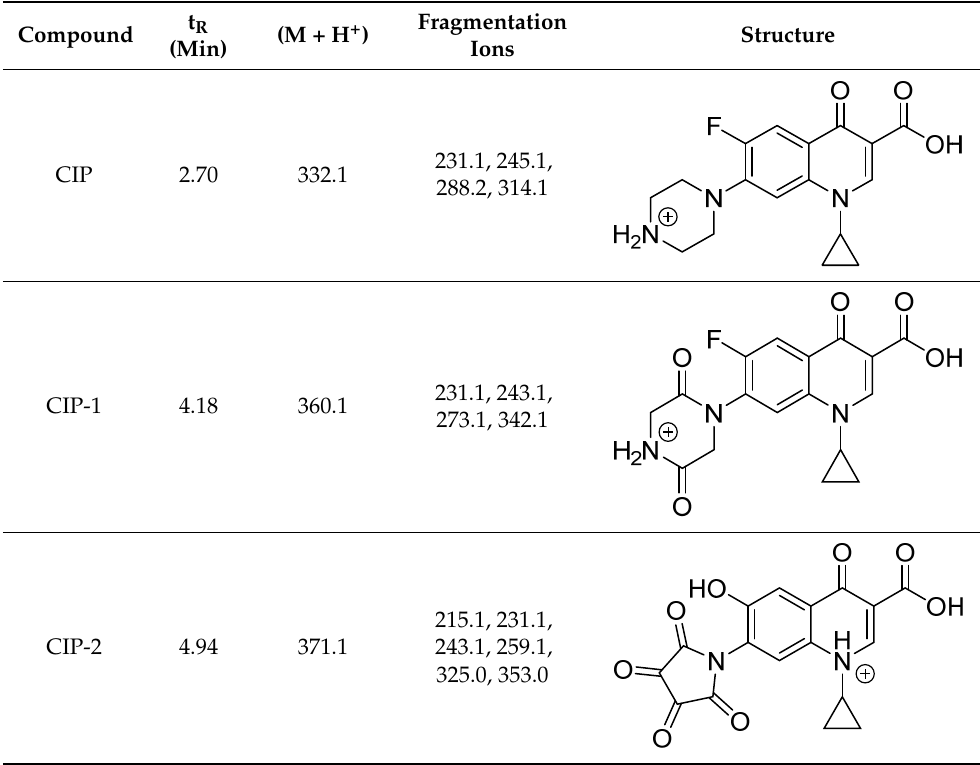
Table 4. Proposed structures of the degradation products of